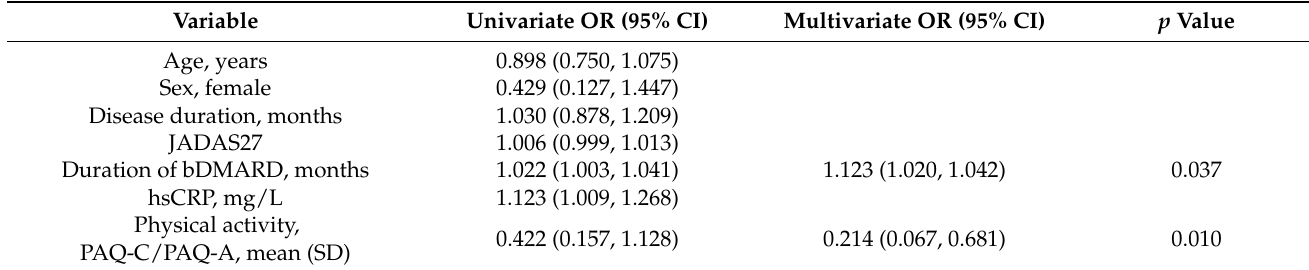
Table 3. Logistic regression model of factors associated with overweight/obesity in patients with JIA.